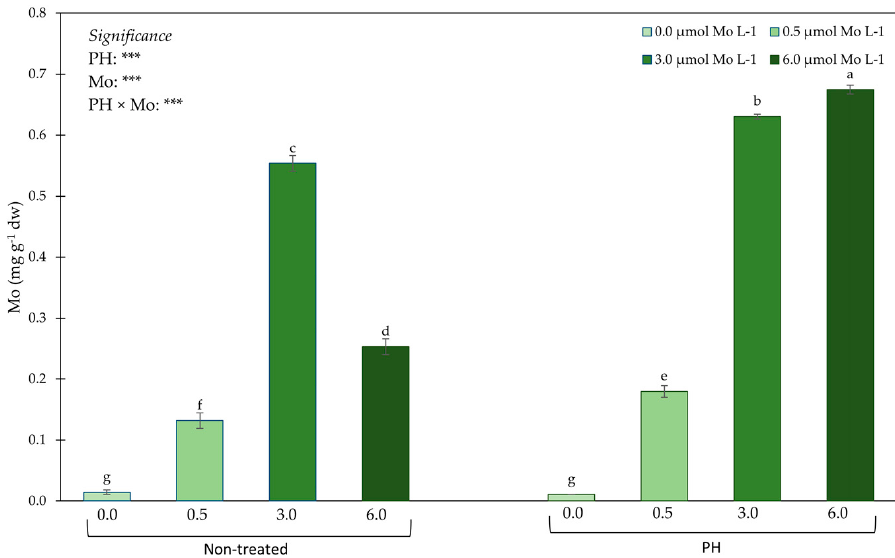
Figure 3. Effects of PHs and Mo treatments on molybdenum concentration in ‘Canasta’ lettuce leaves grown in a protected environment. Values with different letters significantly differ at p ≤ 0.05. *** significant at 0.001.